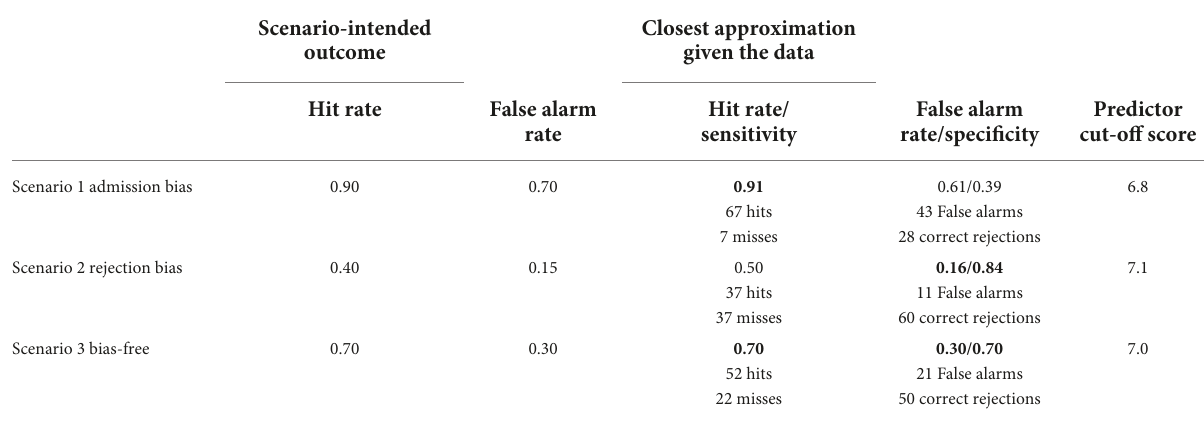
TABLE 3 Selection outcomes for the three possible scenarios.